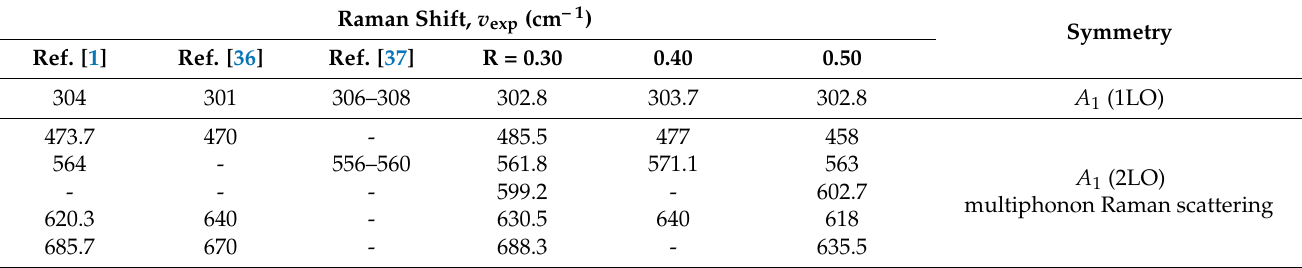
Table 2. Vibration modes found in the Raman spectra of fabricated thin films by the CBD method. Raman Shift, v exp (cm – 1